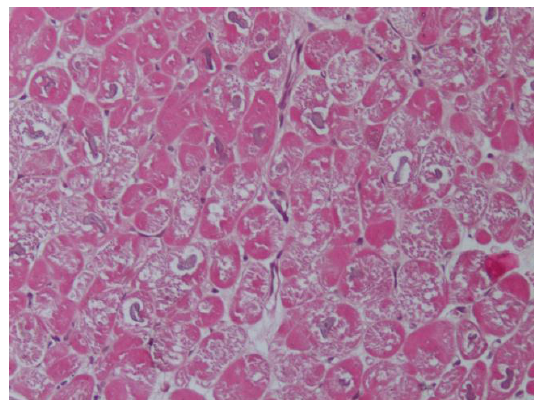
Figure 1. Hematoxylin and eosin staining (200 × ) shows enlarged and vacuolated myocardiocytes due to water